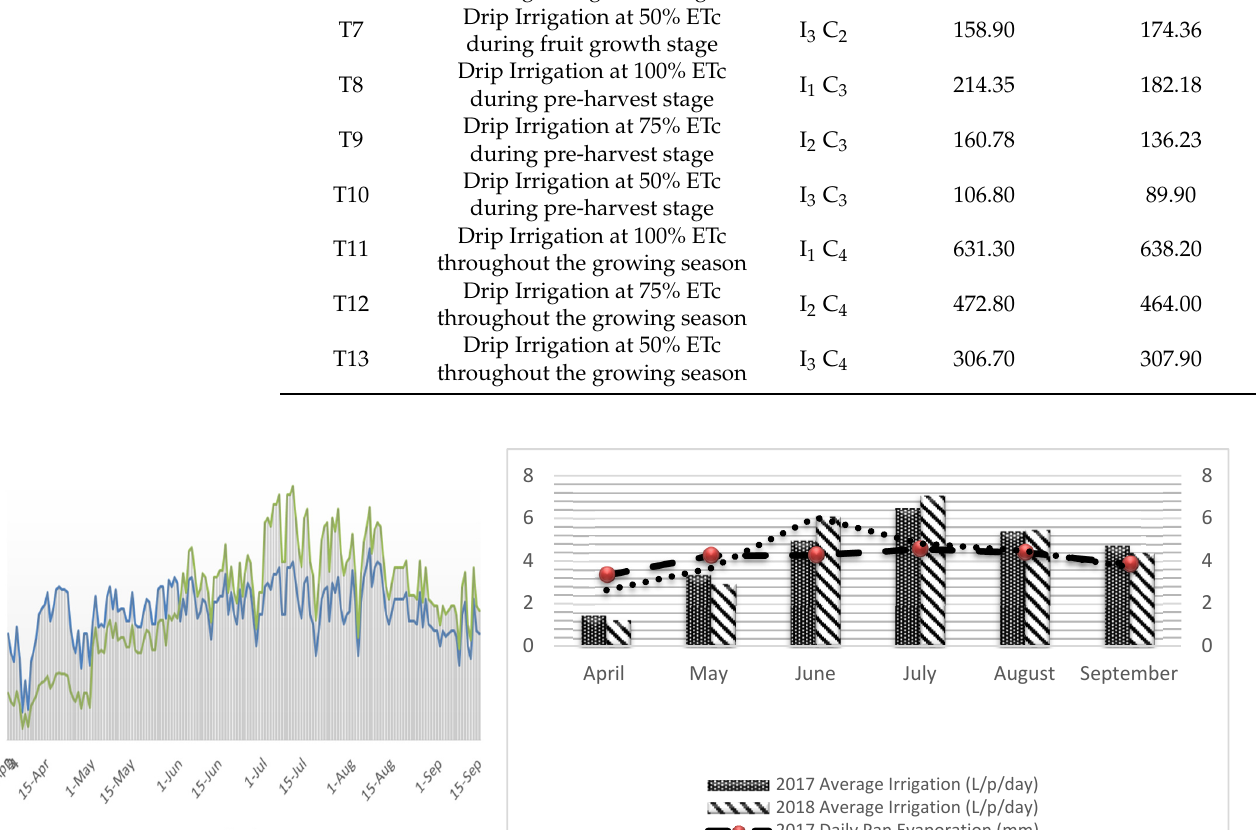
Table 2. Treatment combinations used in the experiment. Treatment Treatment Combination